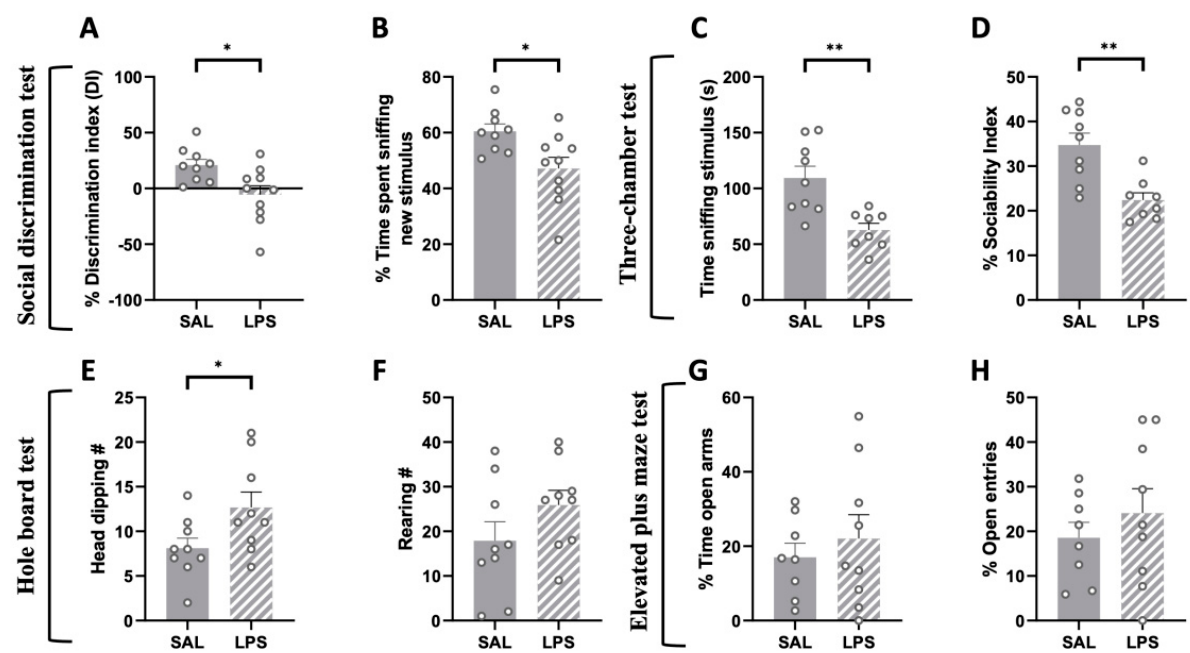
Figure 3. Effects of prenatal LPS exposure in the social discrimination, three-chamber, hole board and elevated plus-maze tests in the adult rat offspring. The social discrimination task revealed impaired social recognition abilities in adult LPS-exposed animals, since they displayed a lower discrimination index ( A ) and spent less time sniffing the new stimulus animal ( B ) compared to control animals (SAL = 9, LPS = 10). Adult LPS-exposed rats showed altered sociality in the three-chamber test ( C , D ) (SAL = 9, LPS = 8). These animals also showed an increased number of head dippings in the hole board task compared to the control group ( E ), with no changes in the frequency of rearing ( F ) (SAL = 9, LPS = 9). No differences between the two experimental groups were found in the ele- vated plus-maze test (% time open arms ( G ); % open entries ( H )) (SAL = 8, LPS = 9). Data represent mean ± S.E.M. * p < 0.05, ** p < 0.01 vs. SAL (Student’s t -test).